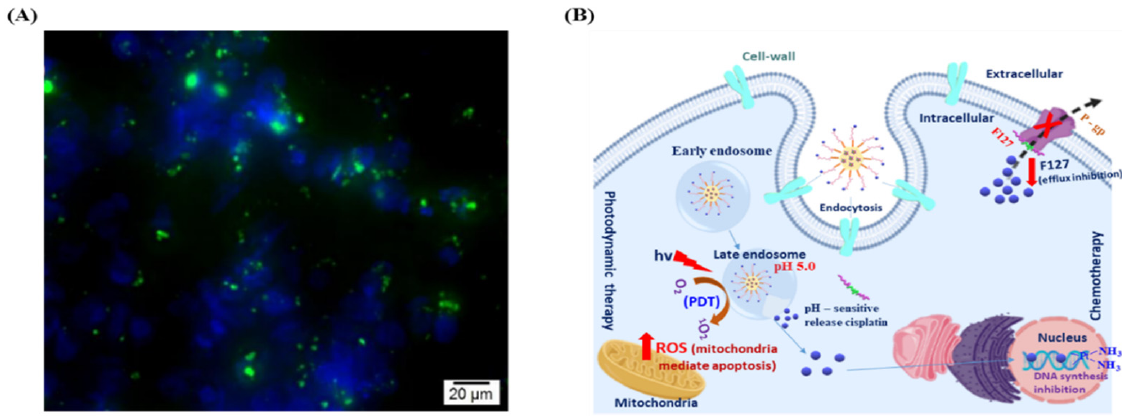
Figure 11. ( A ) IBN-1-Cur-CP nanoparticles (50 μ g/mL) cellular uptake with DAPI nuclear staining (blue), scale bar 20 μ m, and ( B ) schematic illustration of IBN-1-Cur-CP cellular uptake, pH-sensitive drug release, and involvement in chemo- and photodynamic therapy in MES-SA/DX5 cells. 3.8. DCFDA Assay ROS levels in MES-SA/DX5 cells were determined using the DCFDA assay. In general, in the presence of ROS, the DCFDA probe is converted to the green fluorescent compound DCF (Figure 12). The cells were incubated with IBN-1-Cur-CP for 4 h and further exposed to the DCFDA and light source. The generated green fluorescence was observed under fluorescence microscopy.